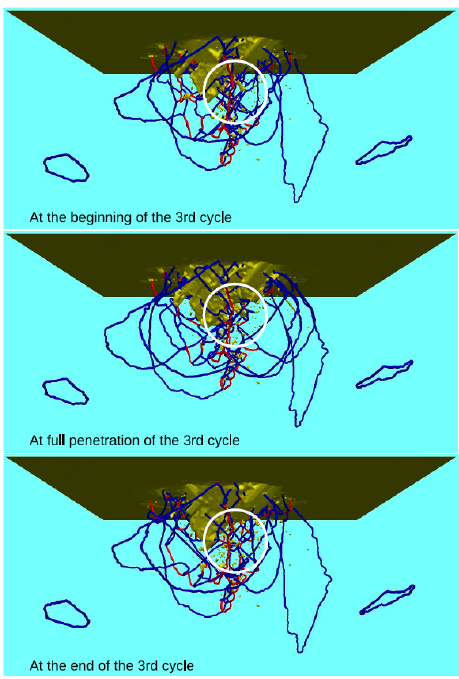
Figure 9. Change of the dislocation structure during the third cycle. Colors denote dislocation type as in Figure 7. The white circle highlights the region where the most changes in dislocation structure occurred during this cycle.